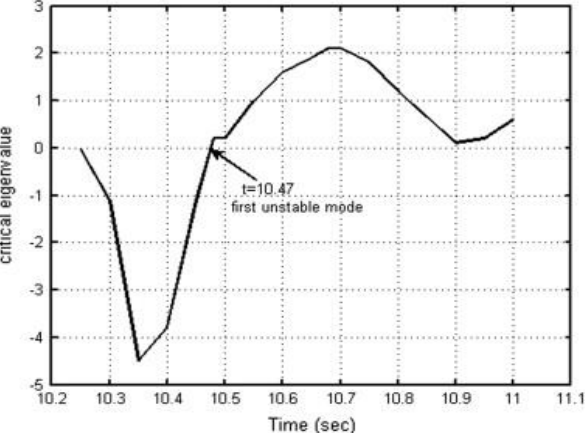
Figure 11. Unstable case of the critical eigenvalue as it rises [56].